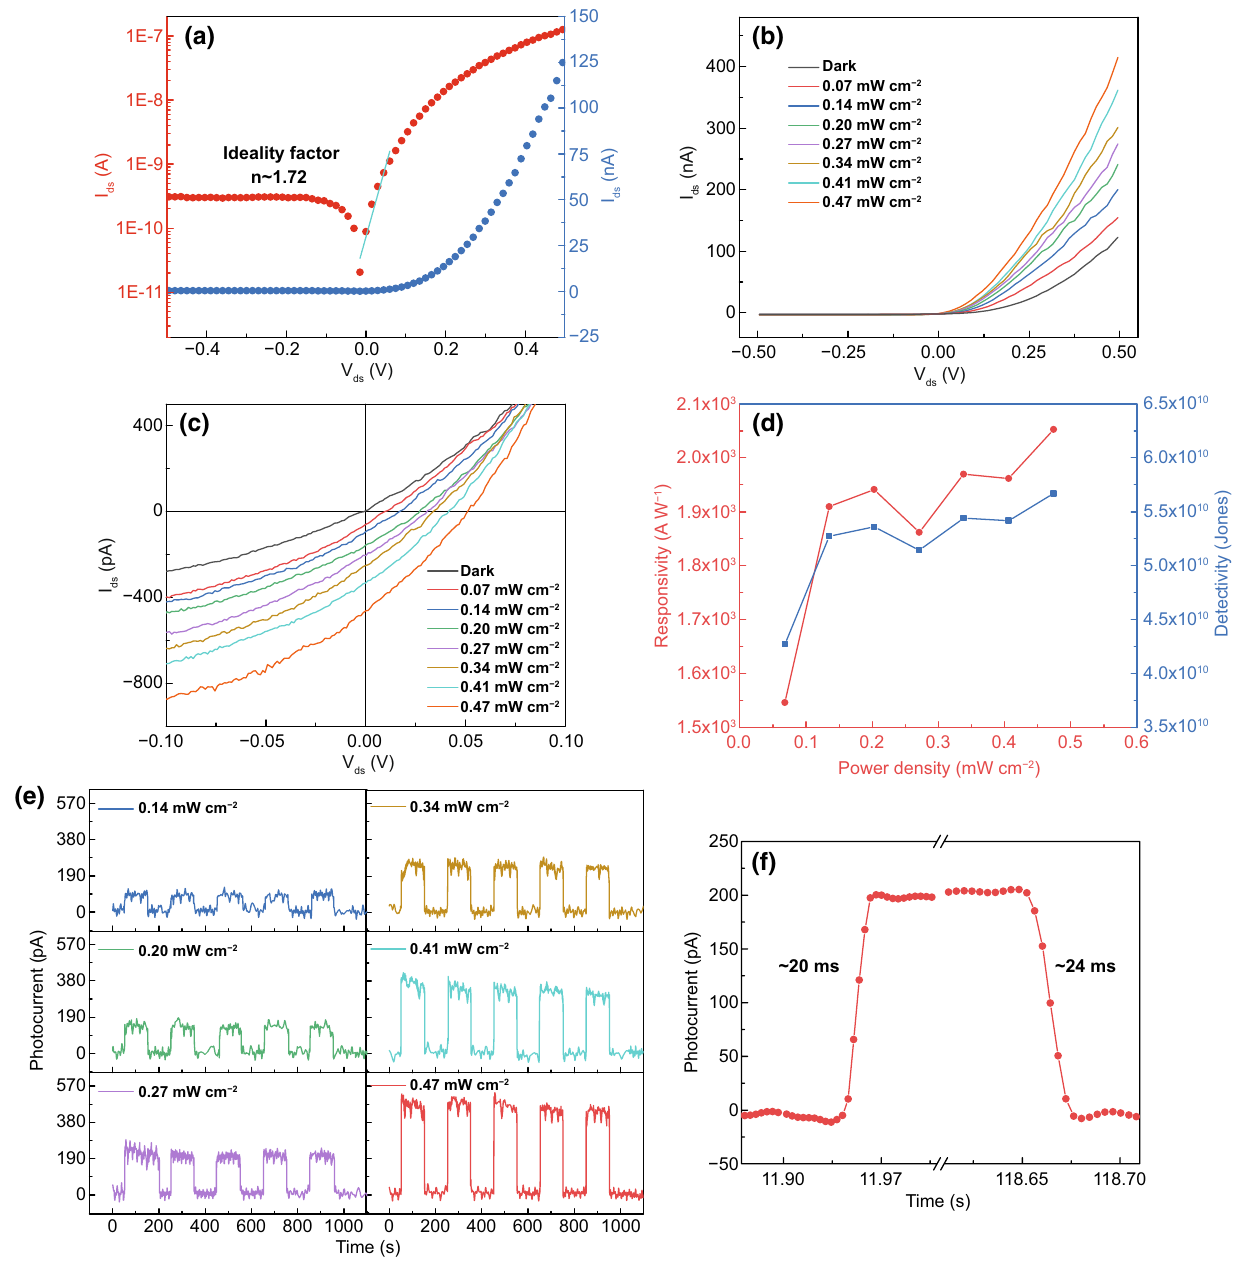
Fig. 2 Electrical characterization and photoresponse from the α-In 2 Se 3 /3R MoS 2 heterojunction under zero strain. a I – V characteristic in the dark with the logarithmic and linear scale. b, c I – V characteristics in the dark and under illumination of 532 nm wavelength under different light intensities from − 0.5 to 0.5 and − 0.1 to 0.1 V, respectively. d Responsivity and detectivity at a bias voltage of 0.5 V as a function of illumina- tion intensities. e Current vs time under 532 nm illumination with several intensities and zero bias voltage. f Current vs time extracted from e under the illumination intensity of 0.27 mW cm